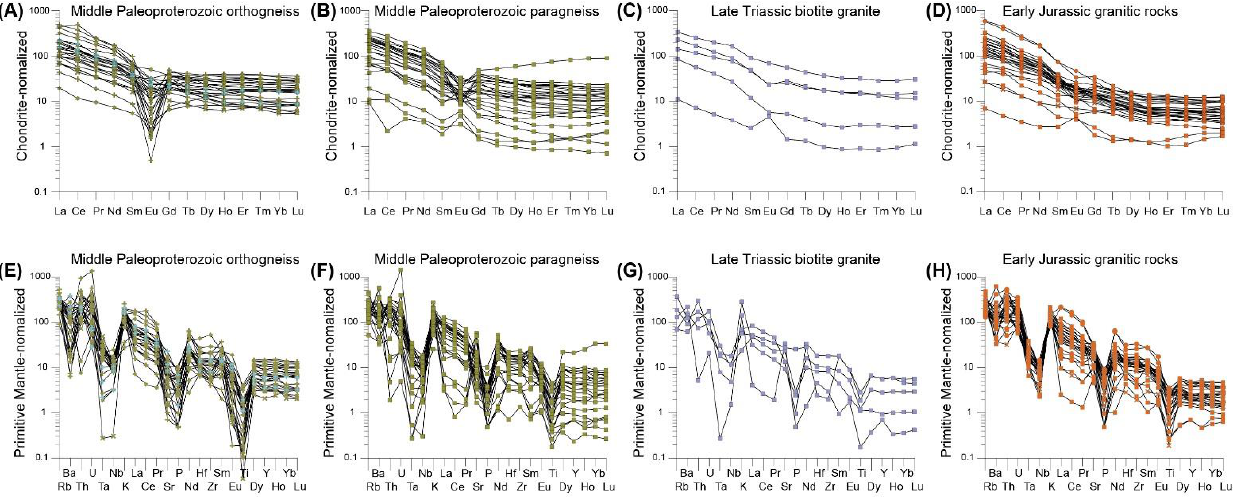
Figure 9. ( A – D ) Chondrite-normalized rare earth element (REE) patterns, and ( E – H ) primitive mantle-normalized trace element distribution diagrams [31] for the Middle Paleoproterozoic orthogneisses, biotite gneisses, Late Triassic granite and Early Jurassic granitic rocks in the Jangsu-gun area. Symbols are as in Figures 6 and 7.